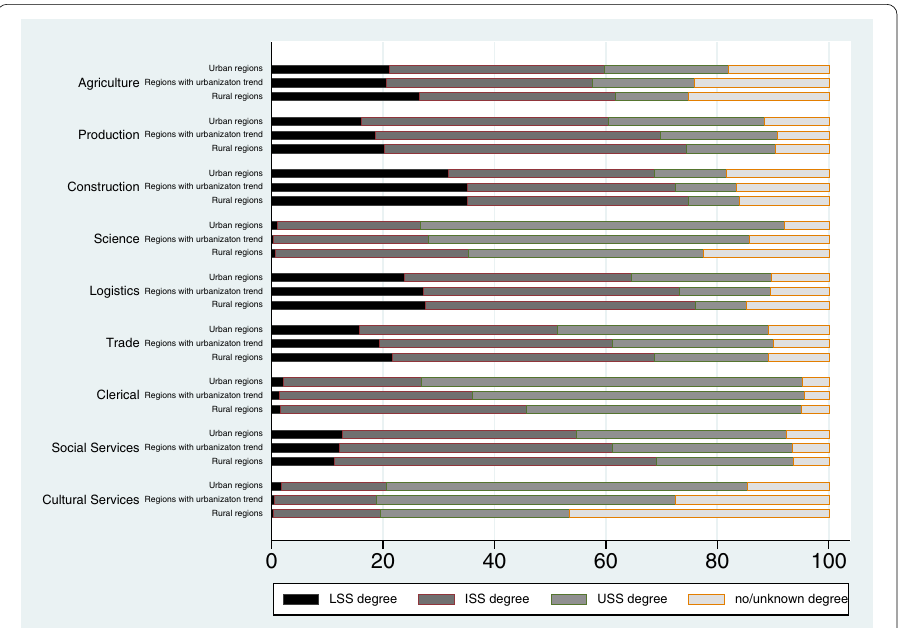
Fig. 2 Share of trainees by KldB 2010, school degree and type of region in 2017/2018. Data source: (Statistik der Bundesagentur für Arbeit